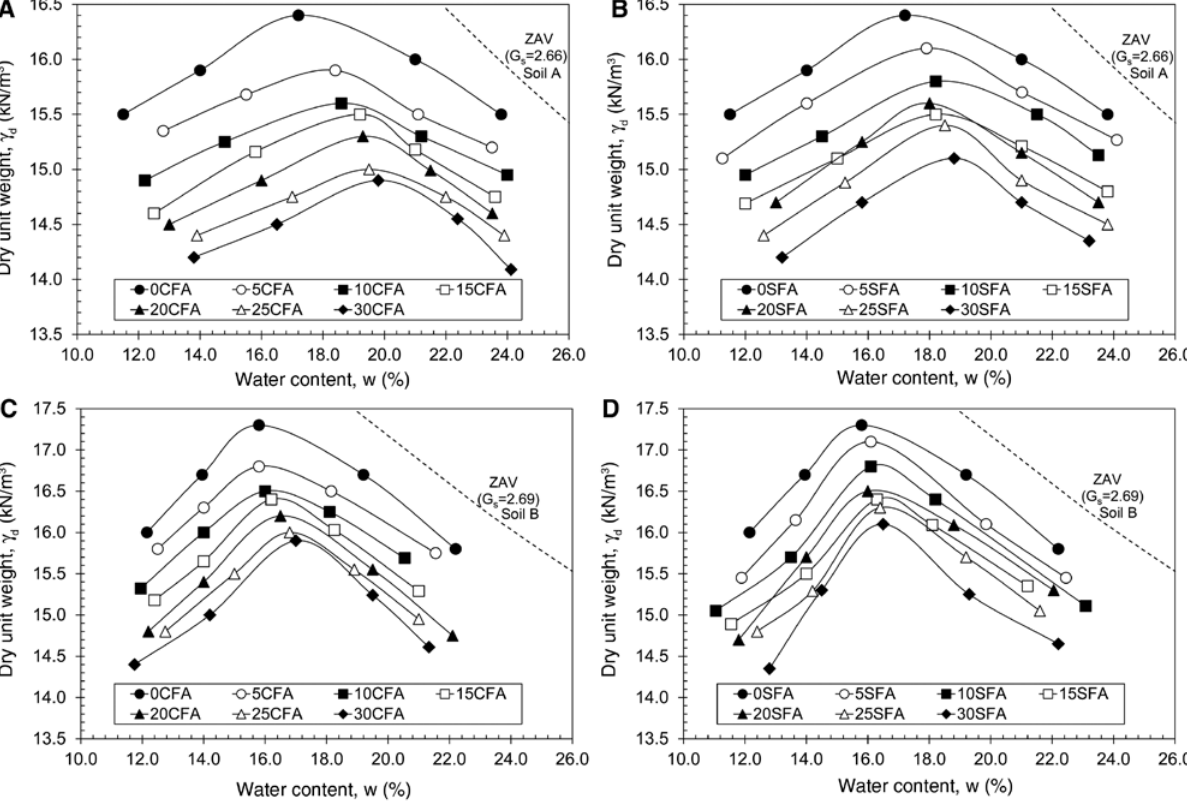
Figure 6: Proctor’s compaction curves for mixtures (A) Soil A-CFA mixtures, (B) Soil A-SFA mixtures, (C) Soil B-CFA mixtures and (D) Soil B-SFA